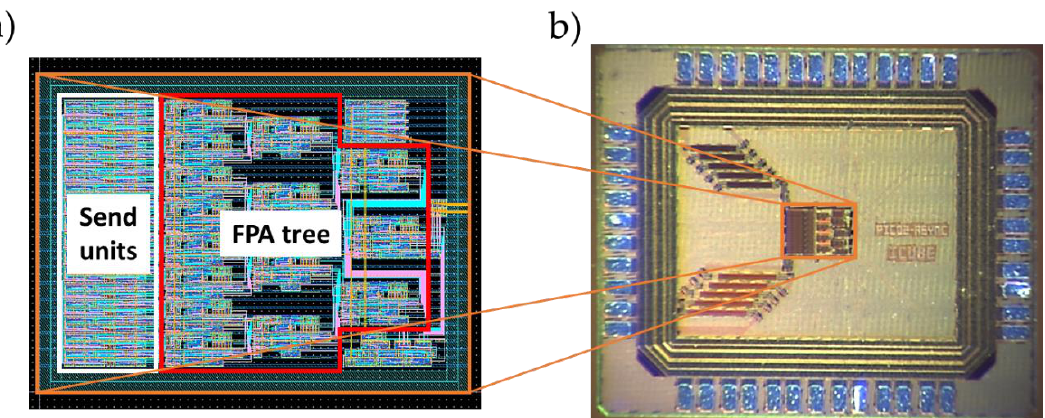
Figure 11. ( a ) FPA tree layout. ( b ) The full device front view by